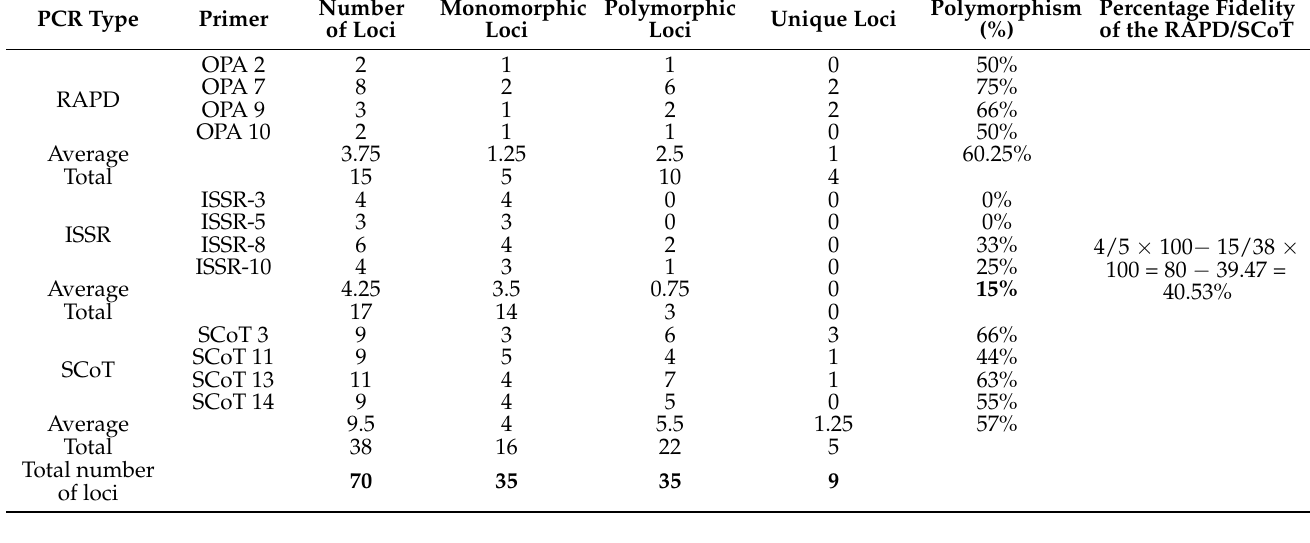
Table 1. Numbers of loci; total, monomorphic, polymorphic, and unique, generated by four out of ten primers of each RAPD, ISSR and SCot-PCR reaction in five kalanchoe genotypes, and the associated polymorphism.